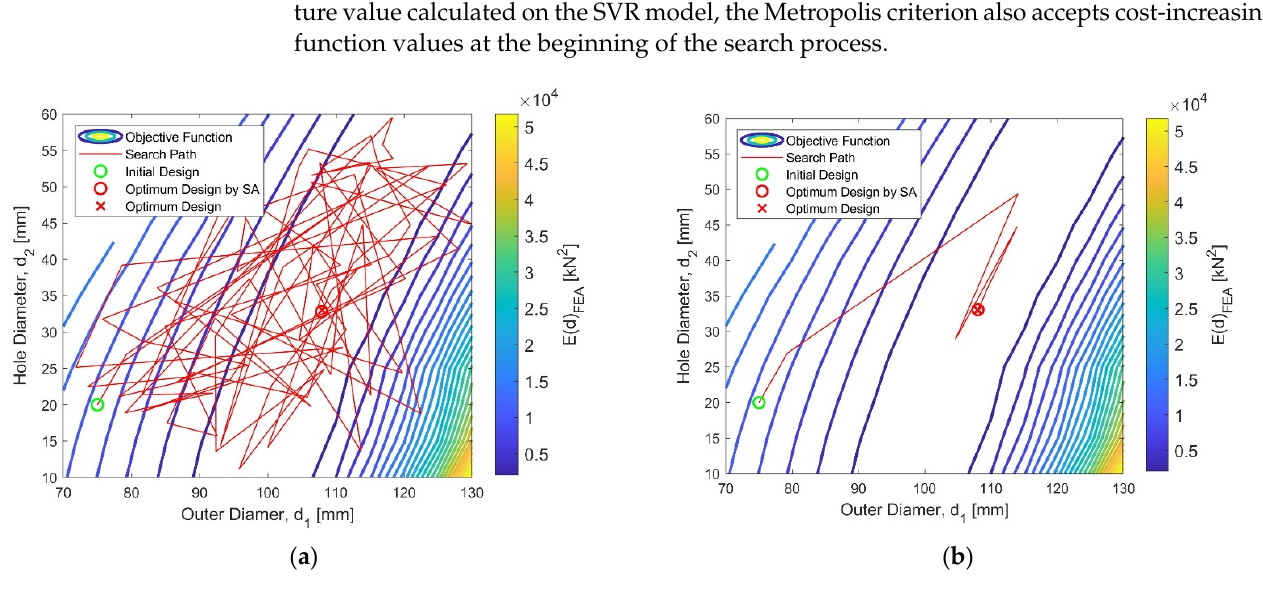
Figure 9. ( a ) Candidate designs accepted by the SA algorithm’s Metropolis criterion. ( b ) Steps accepted with cost function reduction.